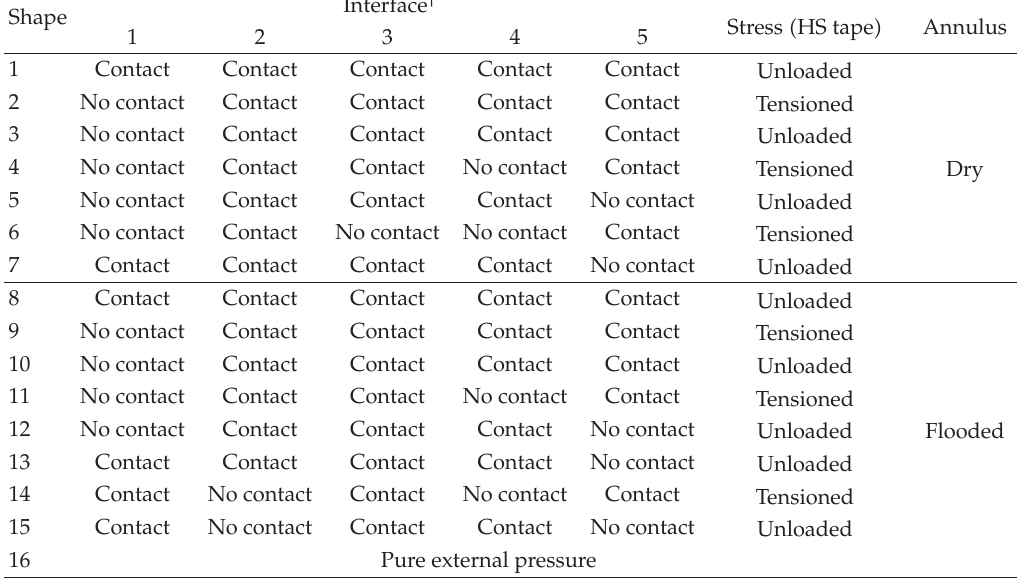
Table 1: Possible contact pressures and stress in the high-strength (cid:3) HS (cid:4) tape for a typical unbonded flexible pipe considering di ff erent annulus conditions and axisymmetric